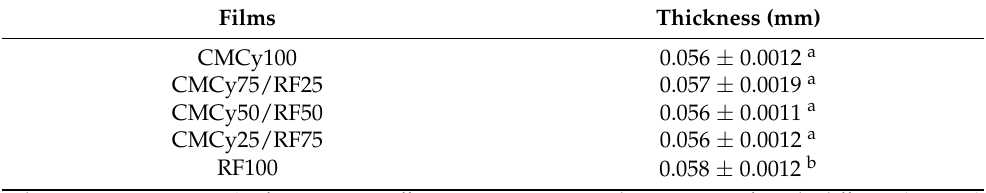
Table 1. The thickness of the CMCy/RF composite biopolymer films produced in different proportions.